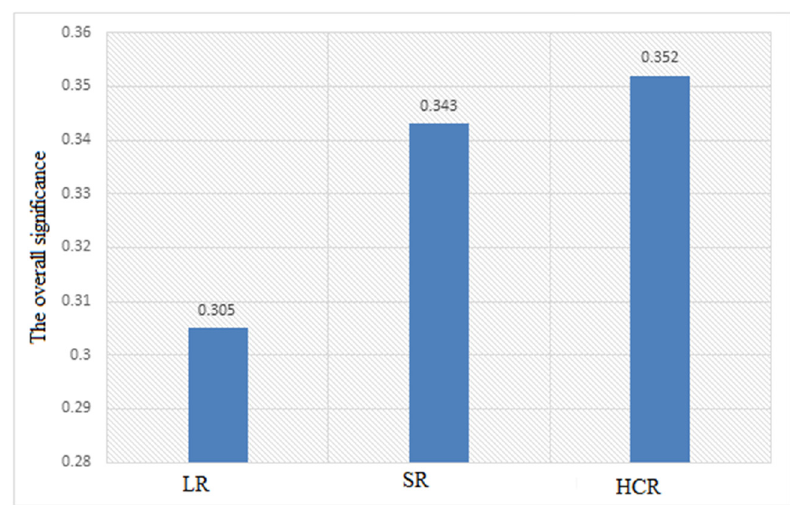
Figure 7: The overall signi fi cance of the alternatives regarding the